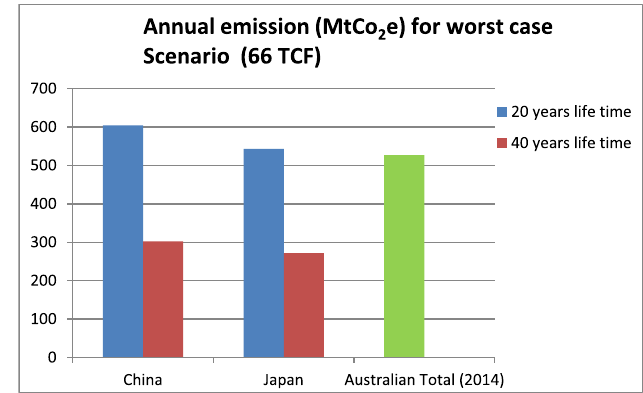
Fig. 6. Comparison with Australian national GHG emissions (2014) in worst case